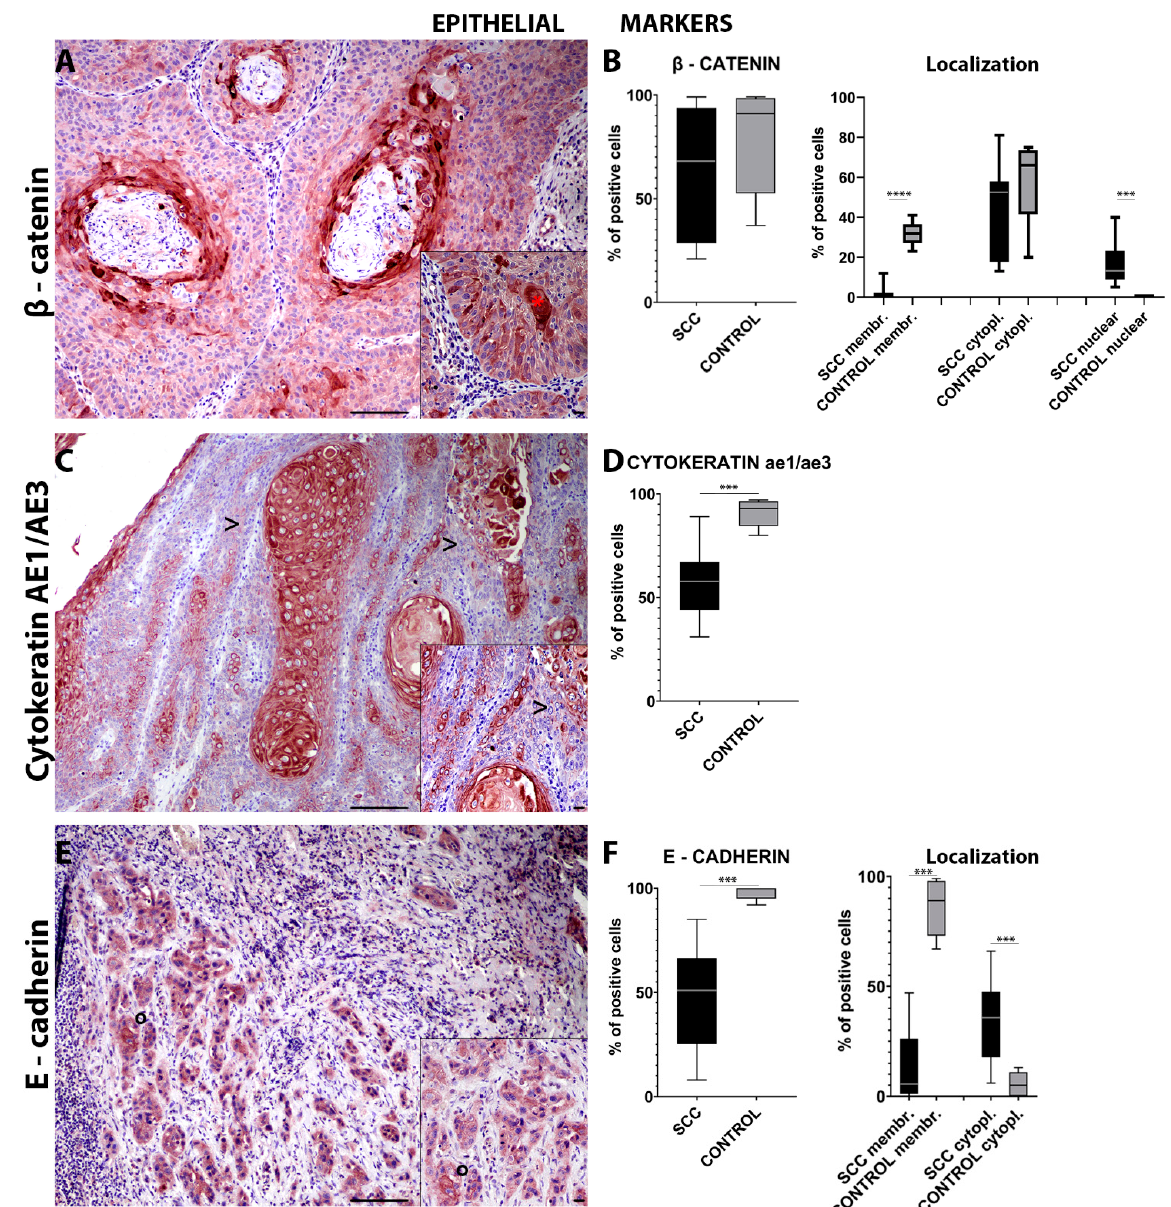
Figure 1. Immunohistochemistry for β -catenin ( A ) in the invasive front of equine penile squamous cell carcinoma (epSCC) shows cytoplasmic and nuclear immunolabeling of the tumor cells (*—( A ) insert). Box-and-whisker plots show a slightly lower number of cells immunolabeled for β -catenin in the epSCC samples ( B ). Box-and-whisker plots showing control tissue with a higher number of cells expressing membranous β -catenin, control tissue with a higher number of cells expressing cytoplasmic β -catenin, epSCC with a higher number of cells with nuclear β -catenin expression ( B ). Immunohistochemistry for cytokeratin AE1/AE3 ( C ) shows a frequent lack of expression in the cells on the epSCC invasive front (>—( C ) insert). Box-and-whisker plots show a lower number of cell immunolabeled for cytokeratin AE1/AE3 in the epSCC samples ( D ). Box-and-whisker plots showing control tissues with a higher number of cells expressing cytoplasmic cytokeratin AE1/AE3 ( D ). Immunohistochemistry for E-cadherin ( E ) shows an occasional membranous expression in the cells on the epSCC invasive front ( ◦ —( E ) insert). Box-and-whisker plots show a lower number of cells immunolabeled for E-cadherin in the epSCC samples ( F ). Box-and-whisker plots showing control tissues with a higher number of cells expressing membranous E-cadherin and epSCC samples with a higher number of cells expressing cytoplasmic E-cadherin ( F ). Scale bar = 100 µ m and scale bar-insert = 20 µ m. All graphs represent box-and-whisker plots with *** p ≤ 0.001 and **** p ≤ 0.0001. SCC: squamous cell carcinoma group; SCC cytopl: squamous cell carcinoma group cytoplasmic; SCC membr: squamous cell carcinoma group